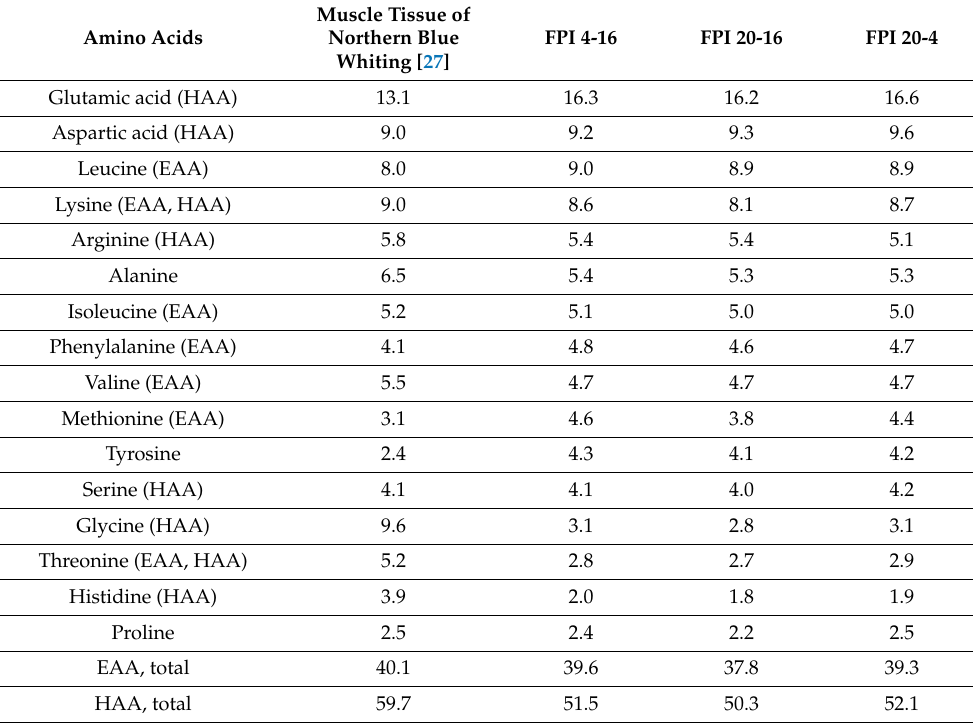
Table 2. Amino acid composition (amino acid content, g/100 g of protein) of raw material and FPI obtained under various conditions (temperature and duration) of alkaline solubilisation. Amino